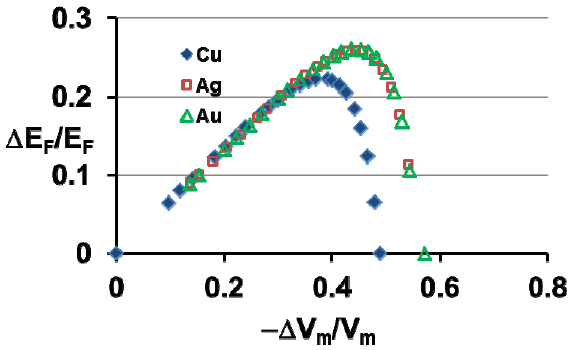
Figure 10. Relative Fermi energy change between superclusters and liquid. The Δ E plotted as a function of the relative volume change Δ V the molar volume of the supercluster having an infinite